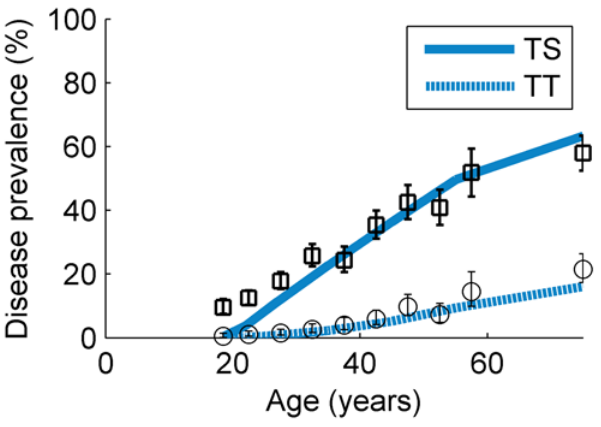
Figure 5. The age-dependent prevalence of the disease sequelae in a hyperendemic setting. Prevalence curves for trachomatous scarring (solid line) and trachomatous trichiasis (dotted line) are shown along with the data from [28] (circles (TS) and squares (TT) and 95%CI error bars), which were collected from the same district as the data of West et al. [25] during the mid-1990s, prior to drug treatment interventions. An assumption made here is that the incidence of the sequelae did not change over the decade prior to the first mass drug administration.